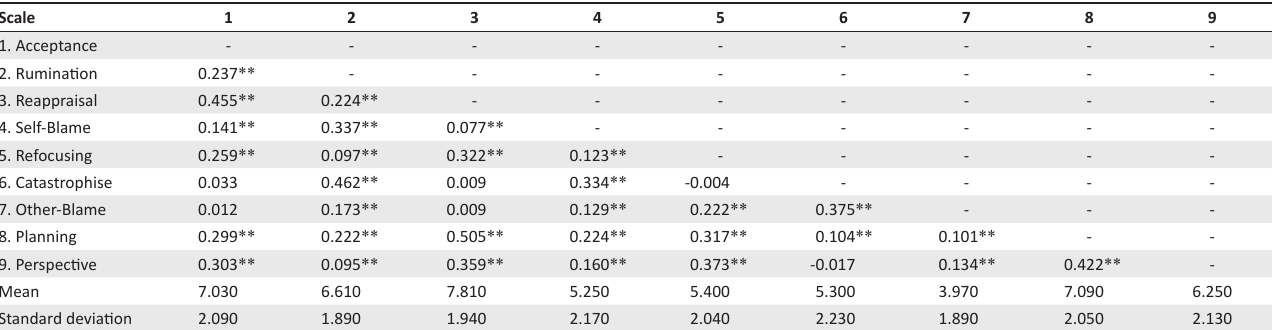
TABLE 1: Zero-order intercorrelations and descriptive statistics for the scales of the Cognitive Emotion Regulation Questionnaire-short. Scale